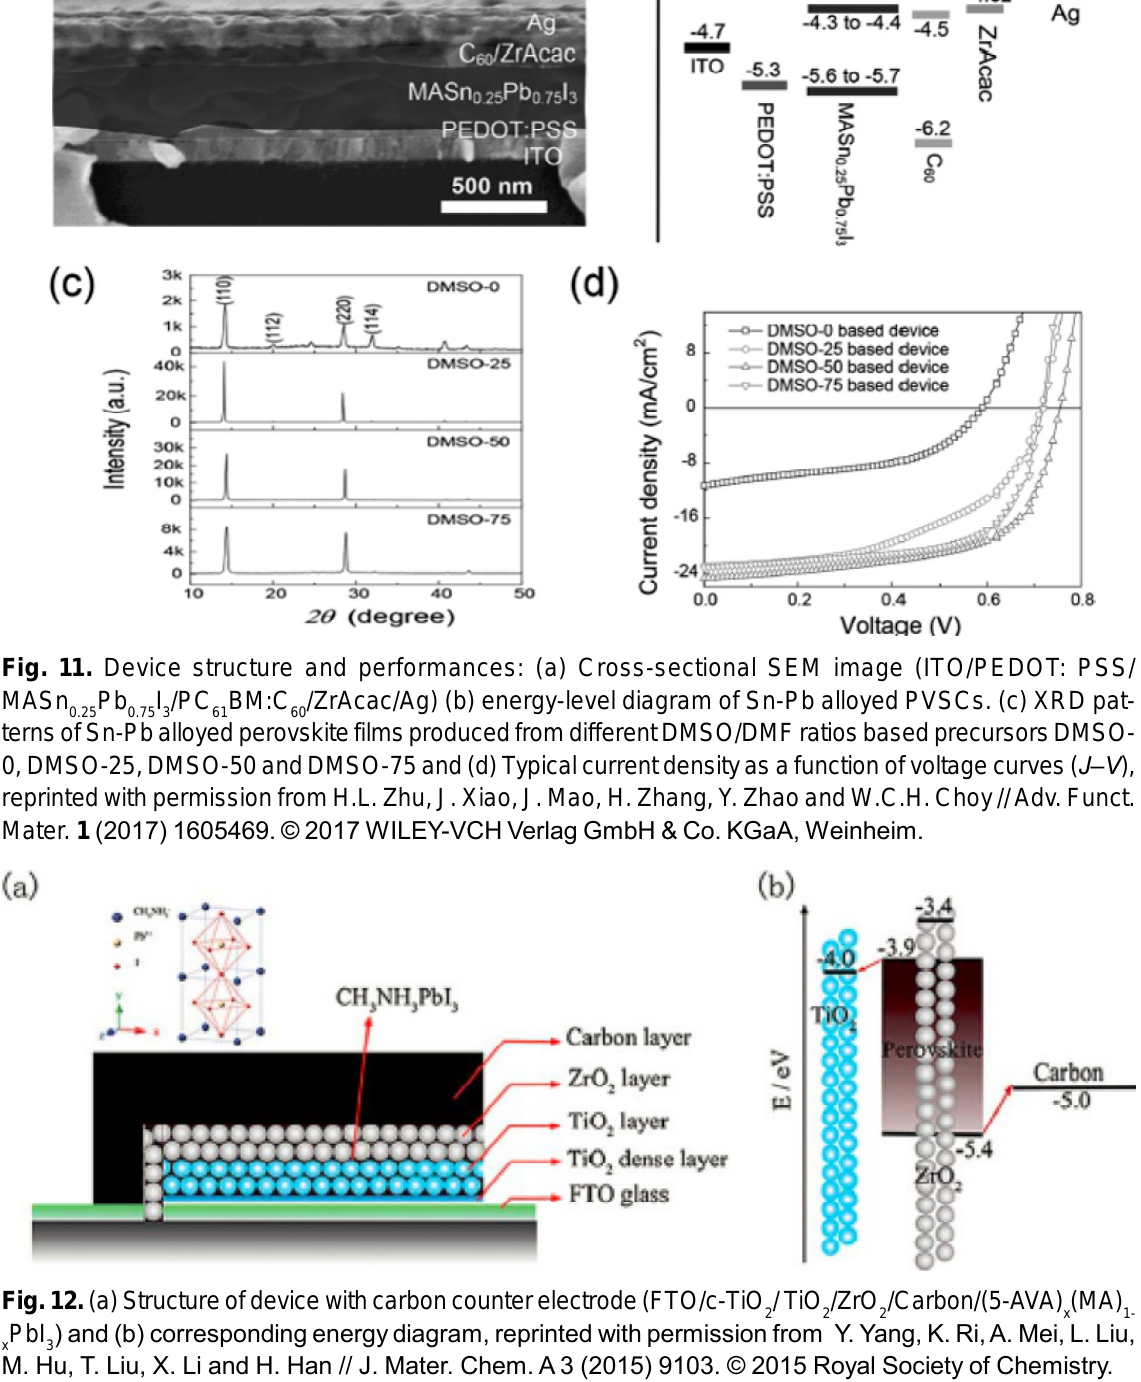
/ TiO /ZrO /Carbon/(5-AVA) (MA) 2 2 2 x 1-